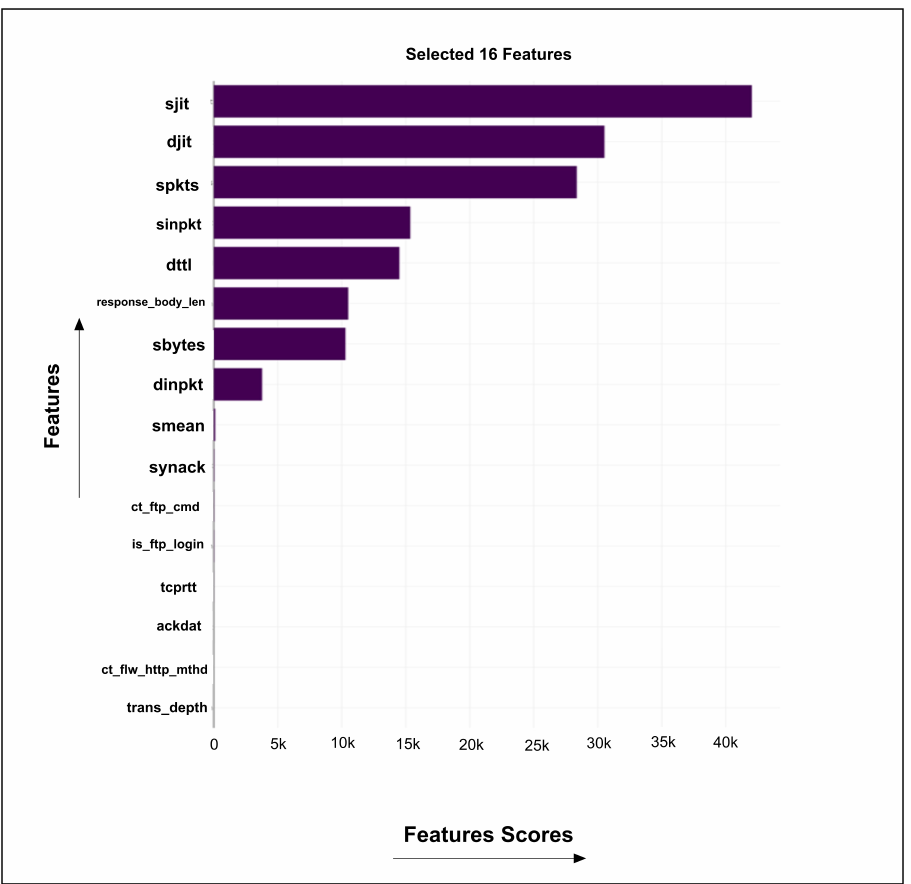
Figure 3. The most valuable 16 features for binary classification using chi-square features